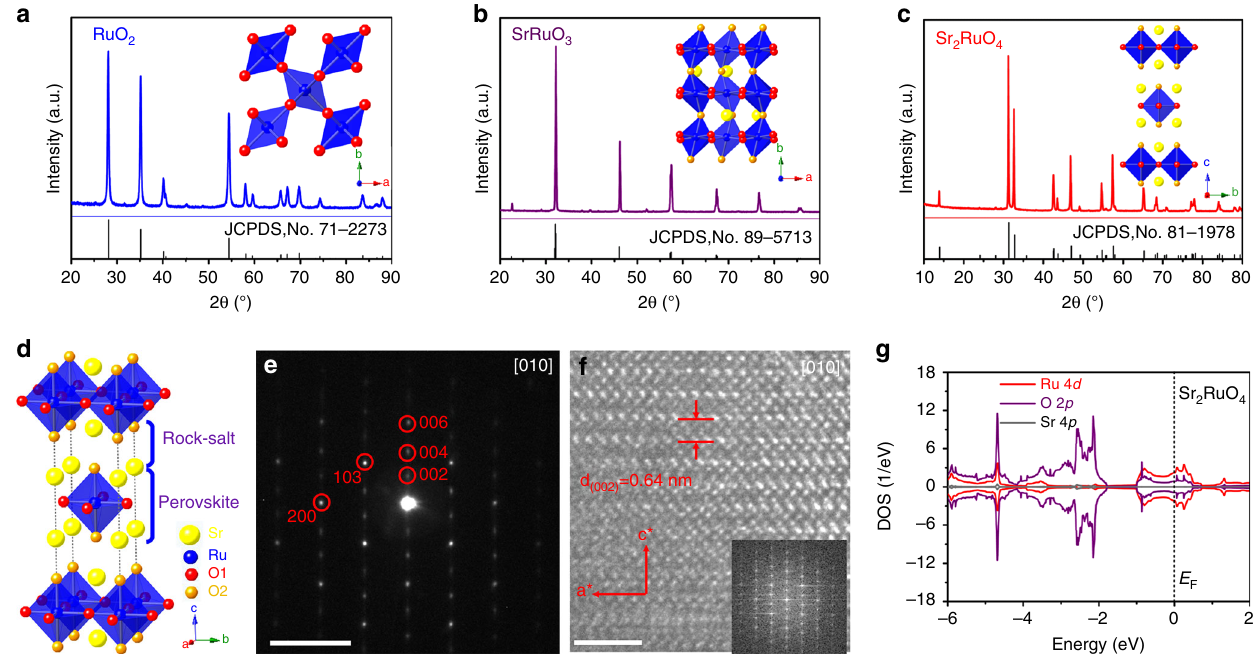
Fig. 1 Bulk structure characterization. XRD patterns of a RuO 2 , b SrRuO 3 , and c Sr 2 RuO 4 . Insert shows the local crystal structure of respective oxide. Color code: Sr (yellow), Ru (blue), and O (red and orange). d Schematic presentation of the layered RP structure of Sr 2 RuO 4 . e SAED pattern and the corresponding HRTEM images ( f ) along the [010] zone axes for Sr 2 RuO 4 . Insert is the FFT. g DFT calculation of the DOS of Sr 2 RuO 4 . Scale bar in ( e ) is 5 nm − 1 and in ( f ) is 2